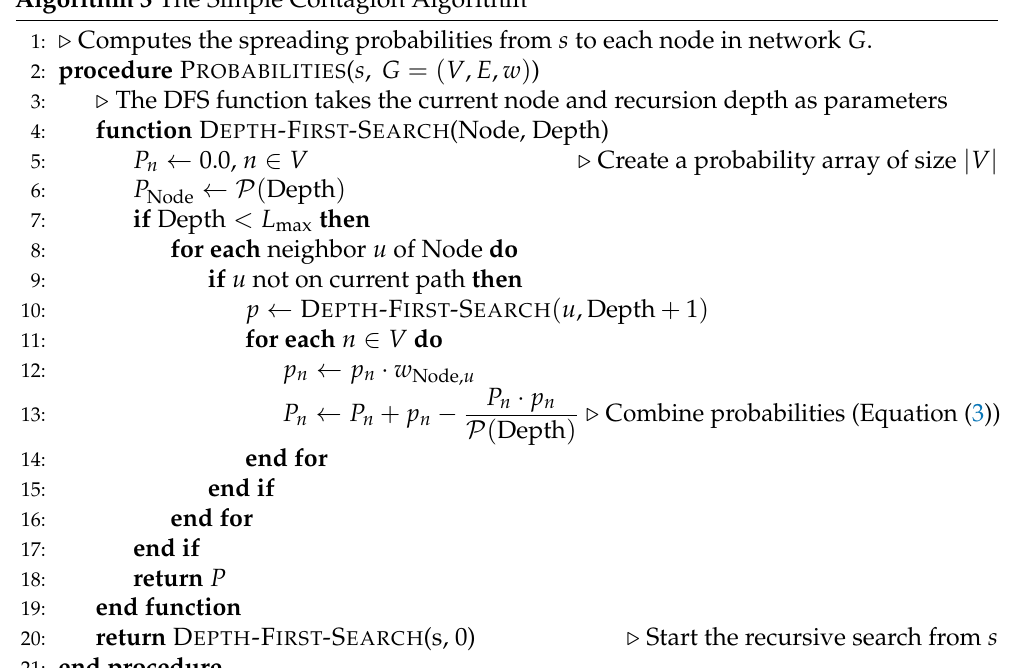
Algorithm 3 The Simple Contagion